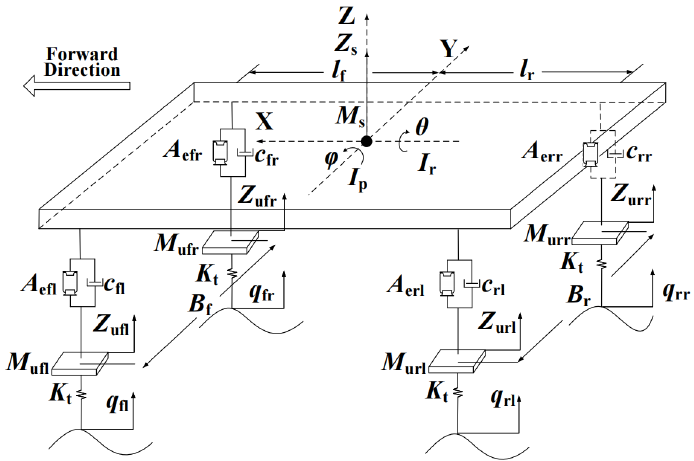
Figure 2. Seven-degree-of-freedom physical model of the full